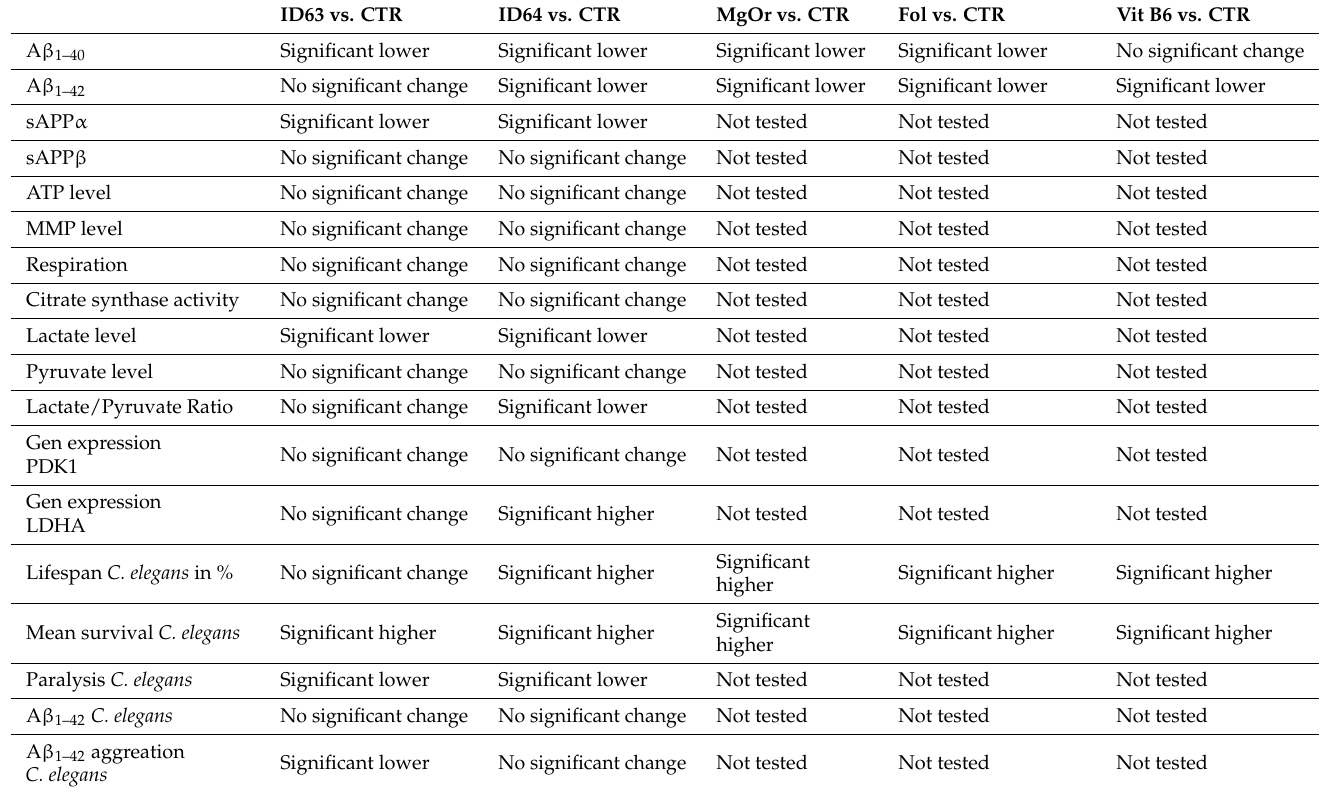
Table 1. General overview of all tests and results of all biofactors. Combinations ID63 and ID64 and the single substances compared to the